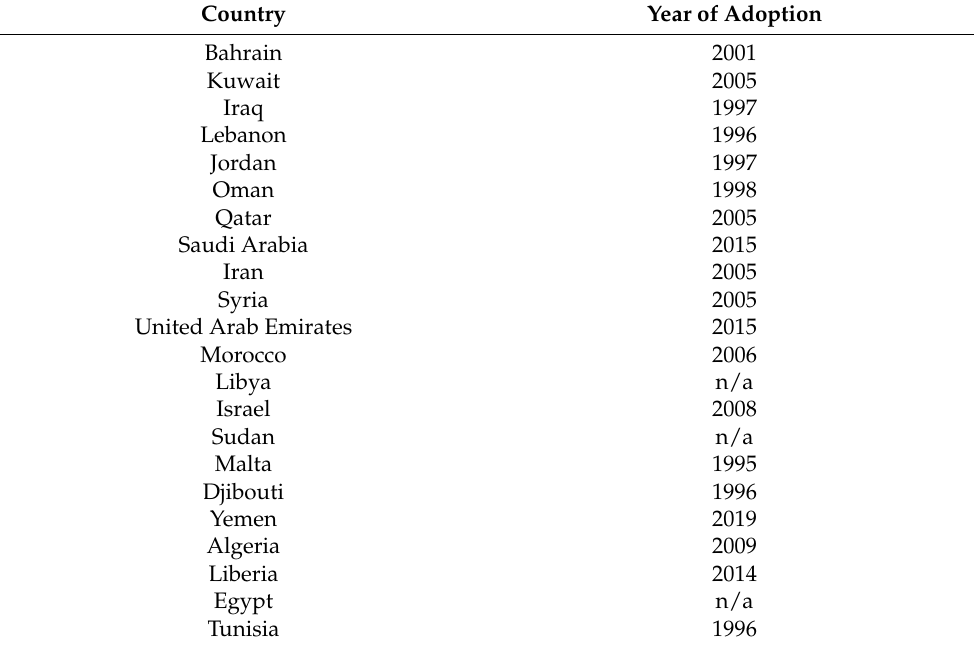
Table A1. IFRS adoption by MENA countries.